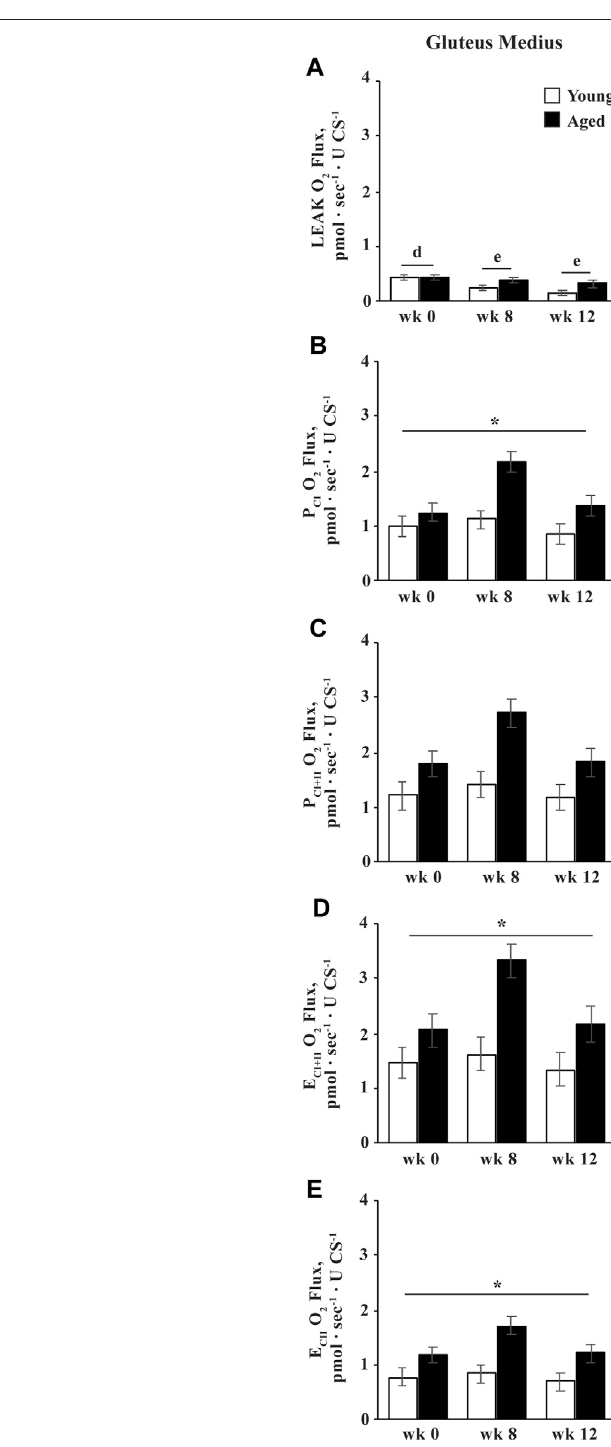
Frontiers in Aging |